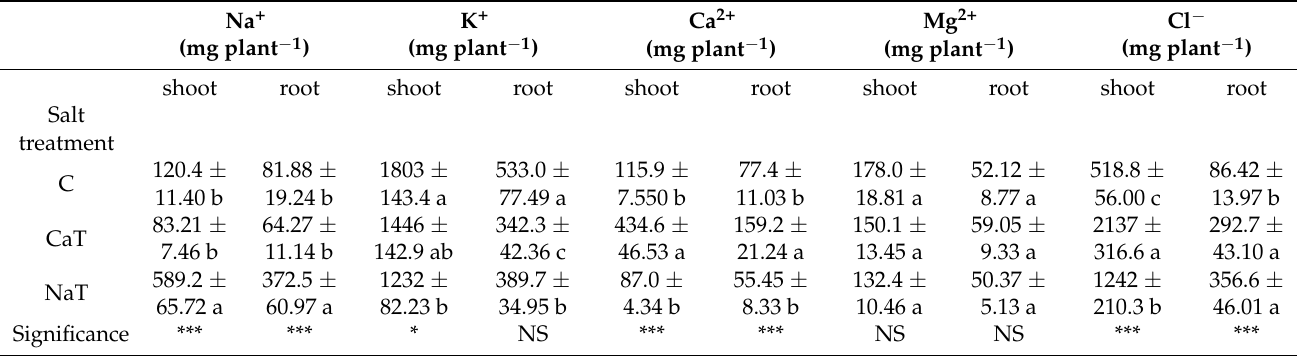
Table 5. Effects of salt treatment in the nutrient solution on shoot and root mineral uptake of the main ionic species (Na + , K + , Ca 2+ , Mg 2+ , Cl − ) in C. citrinus plants. Mean values and standard errors are shown. Different letters correspond to significantly different values ( p < 0.05).